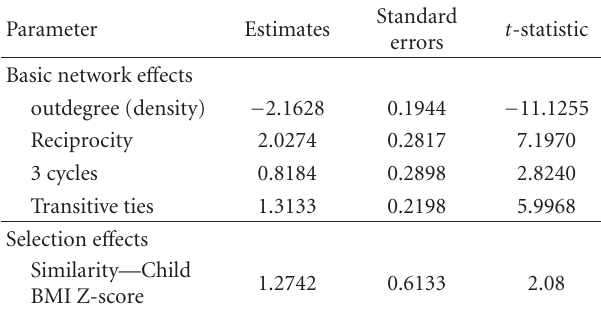
Table 5: Parameter